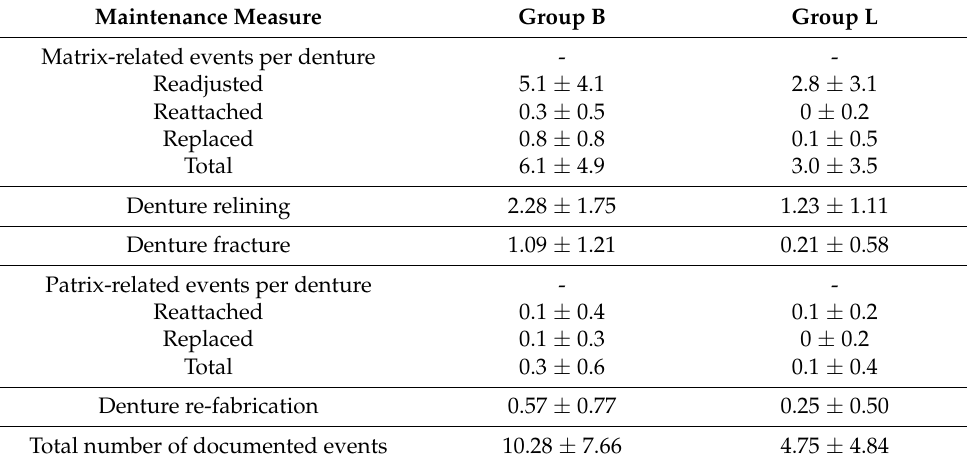
Table 1. Incidence of maintenance measures per denture ( ± SD), showing a decreasing